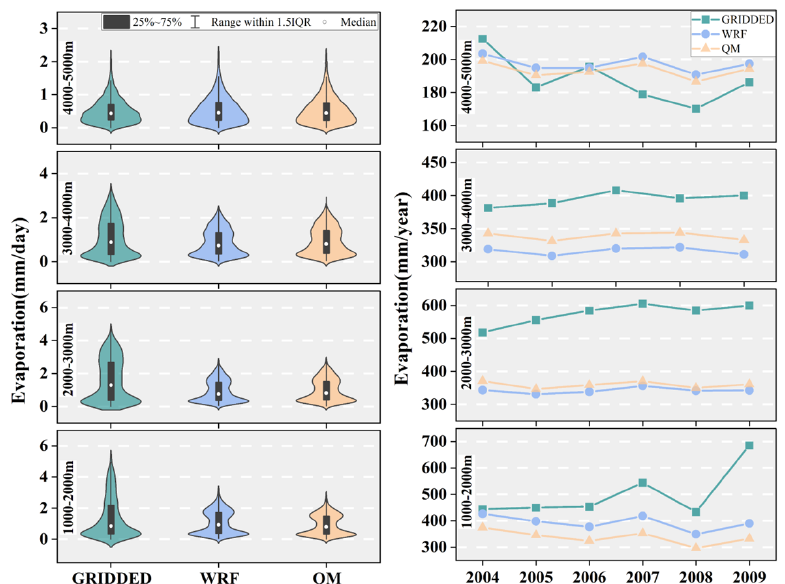
Figure 10. The left displays the altitude-related frequency distribution of simulated evaporation using different datasets (the GRIDDED precipitation, the WRF downscaled precipitation, and the QM frequency-corrected precipitation data), and the right shows the corresponding annual evaporation trend at different altitudes. The IQR used in the legend of the evaporation frequency map denotes interquartile